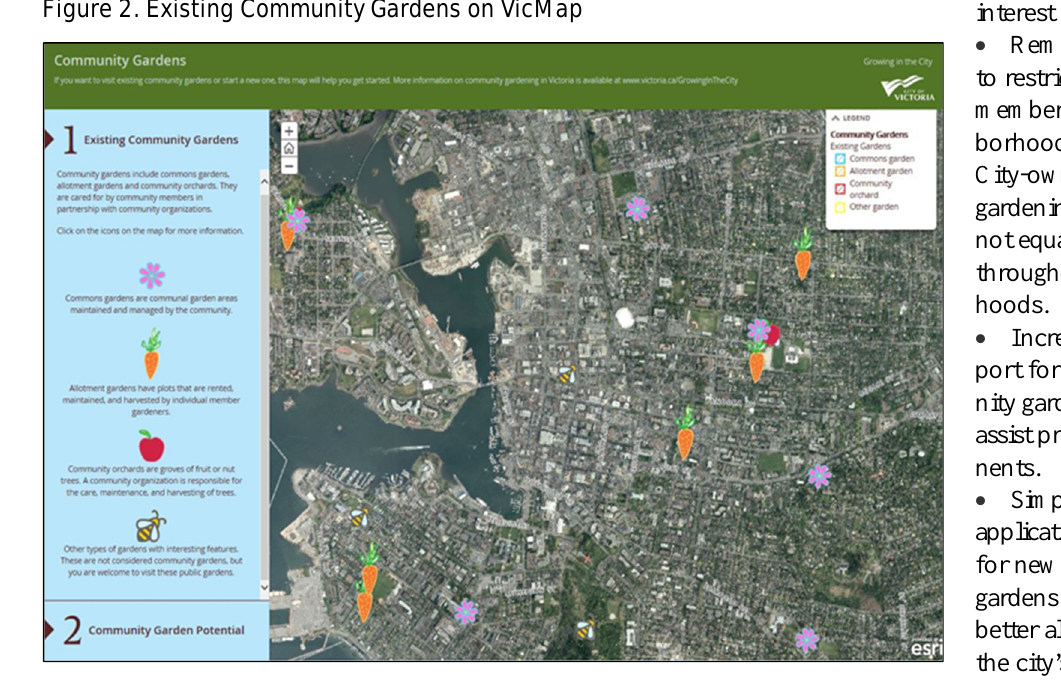
Figure 3. VicMap Inventory of City-owned Land with Community Gardening Potential